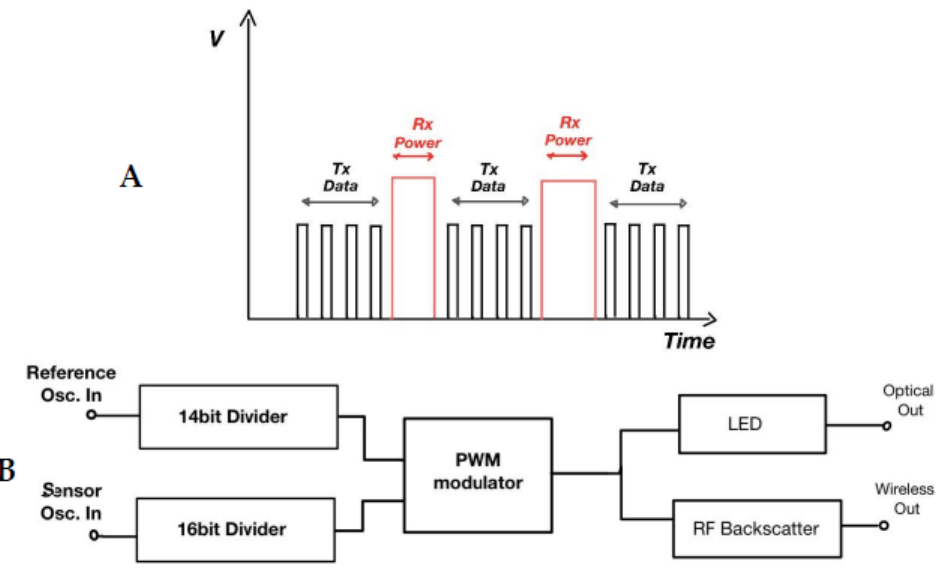
Figure 3. ( A ) µ LED PWM data output pulses and induction power reception. ( B ) Measurements Figure 3. ( A ) µLED PWM data output pulses and induction power reception. ( B ) Measurements transmission via µ LED and/or RF waves. LED: light-emitting silicon diodes, PWM: pulse-width transmission via µLED and/or RF waves. LED: light-emitting silicon diodes, PWM: pulse-width modulation, Osc.: oscillation, RF: radiofrequency, Rx: receive, Tx: modulation, Osc.: oscillation, RF: radiofrequency, Rx: receive, Tx: transmit.